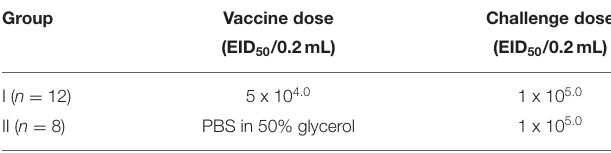
TABLE 2 | Evaluation of duration of immune response and protective efficacy. Group Vaccine dose Challenge